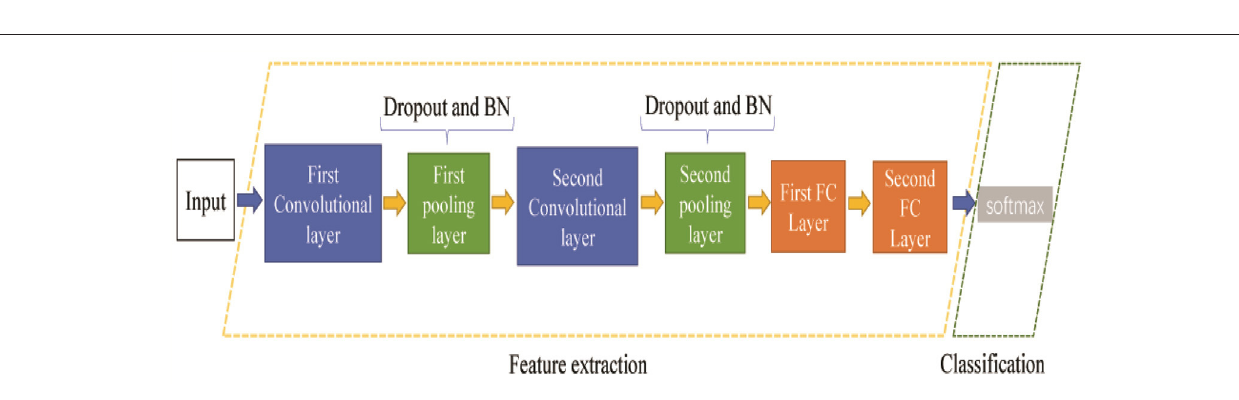
FIGURE 2 | The LeNet-5 structure proposed in this